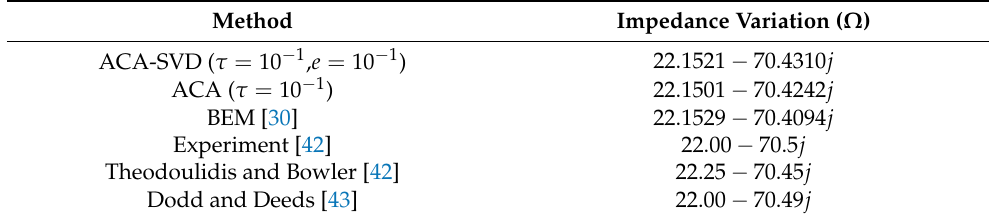
Table 4. Impedance variations predicted by ACA-SVD based BEM, analytical, semi-analytical methods and experiments for placing coil C5 above conducting plate